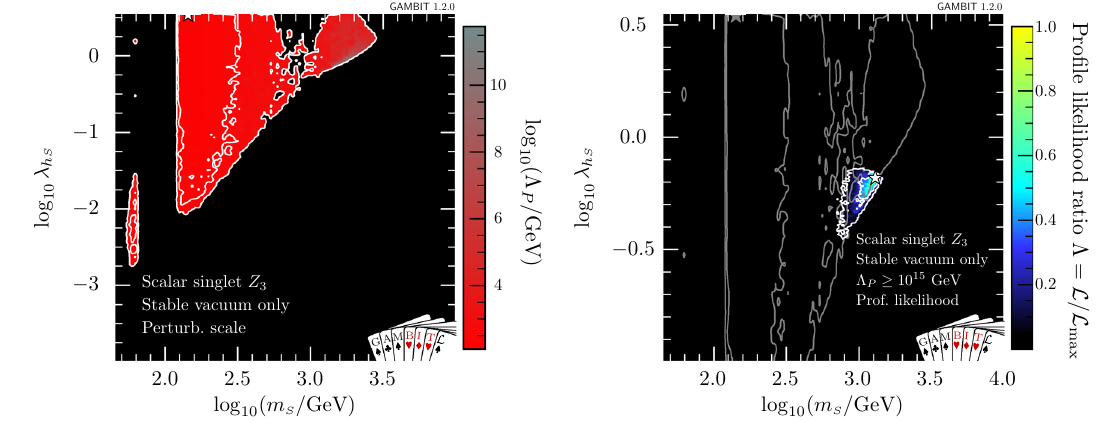
Fig. 12 Left: Scale of perturbativity violation for the Z 3 scalar singlet model with the requirement of a stable electroweak vacuum. Right Pro- file likelihood when also imposing the requirement Λ P > 10 15 GeV.